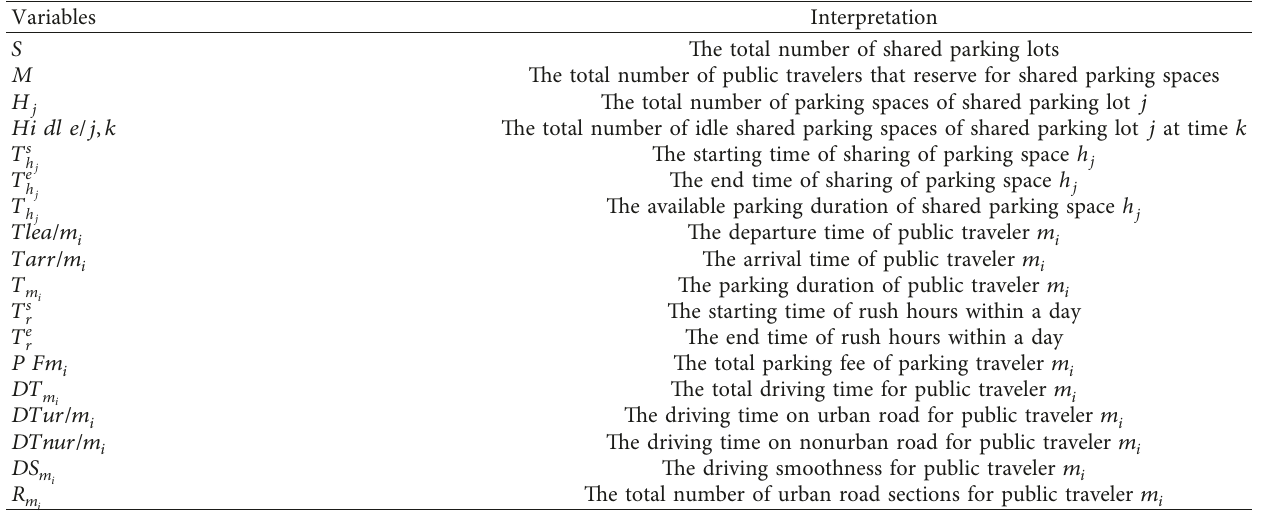
Table 1: Nomenclature list of shared parking